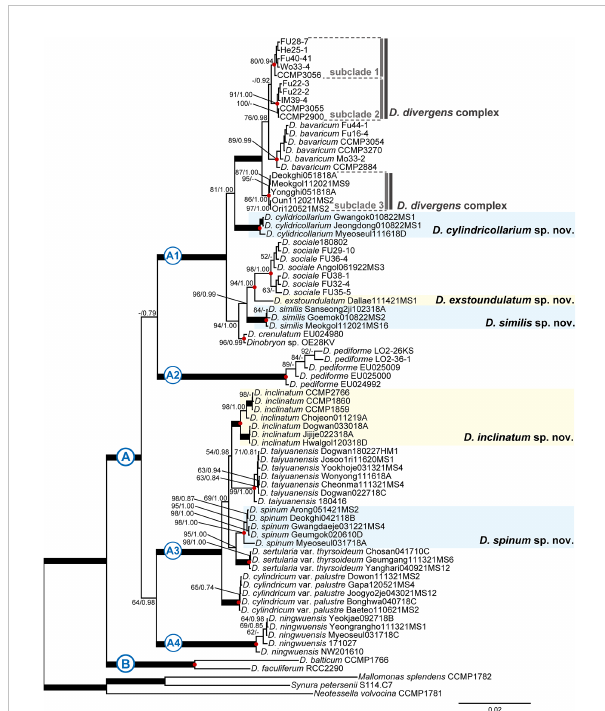
FIGURE 2 Bayesian tree of the genus Dinobryon based on combined nuclear SSU and LSU rDNA and plastid LSU rDNA, rbc L, psa A and mitochondrion CO1 genes data. The maximum-likelihood bootstrap values (MLBS values, left) and Bayesian posterior probabilities (PP, right) are shown at each node. The node of each species-level lineages is indicated by red circles; the scale bar indicates the number of substitutions/site; the thick line indicates full support (100% MLBS and 1.00 PP), and (-) denotes values < 50% for MLBS or 0.70 for